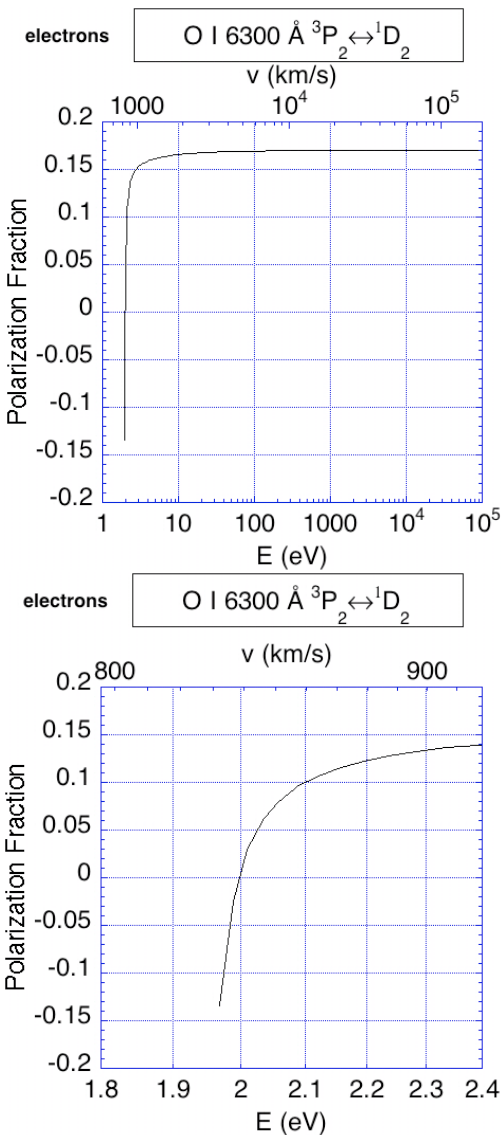
Fig. 2. Impact polarization (linear polarization) due to line col- lisional excitation by directive electrons, as a function of the en- ergy of the colliding electron, which is assumed to propagate along O x , the radiation being observed along O z . A positive polarization means radial polarization, i.e. oriented also along O x , lying inside the scattering plane. A negative polarization means tangential po- larization, i.e. oriented along O y , perpendicular to the scattering plane. Bottom: zooming in around the threshold energy,